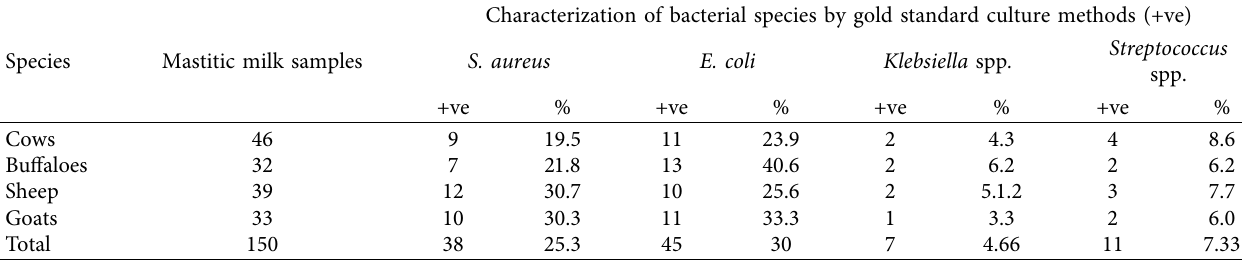
Table 3: Te percentage of bacteria isolated from mastitic milk samples of diferent animals.